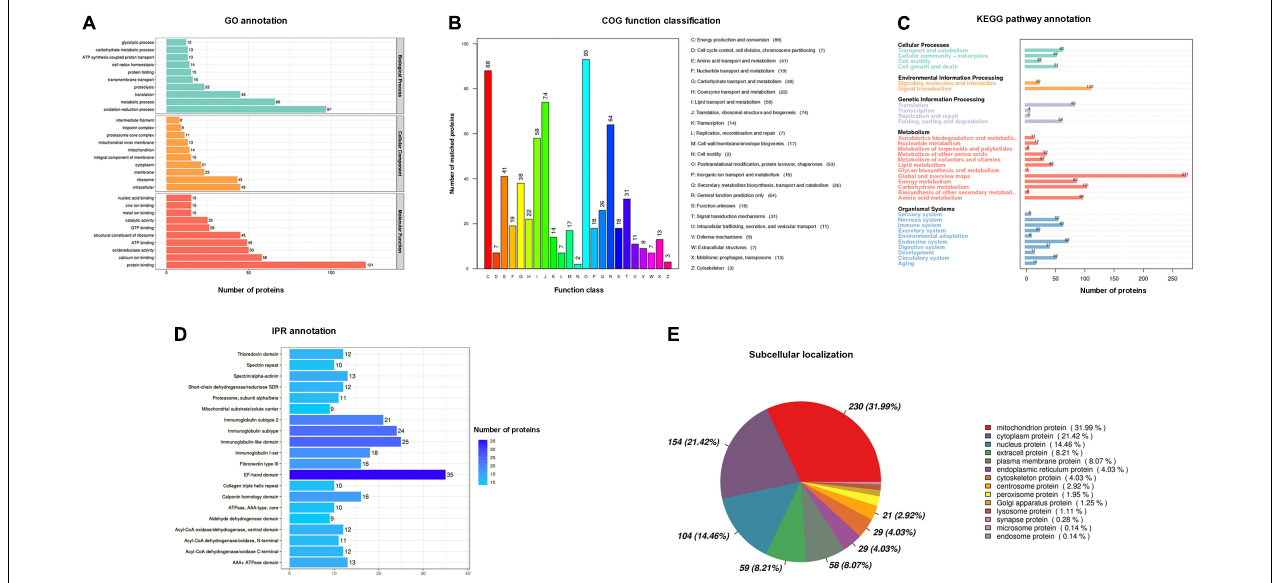
FIGURE 2 | Annotation information of identified proteins in P. dentex skeletal muscle. (A) Gene Oncology (GO) functional enrichment, (B) Cluster of Orthologous Groups of proteins (COG) function classification, (C) Kyoto Encyclopedia of Genes and Genomes (KEGG) pathway enrichment, (D) InterPro (IPR) conserved domain, and (E) subcellular localization